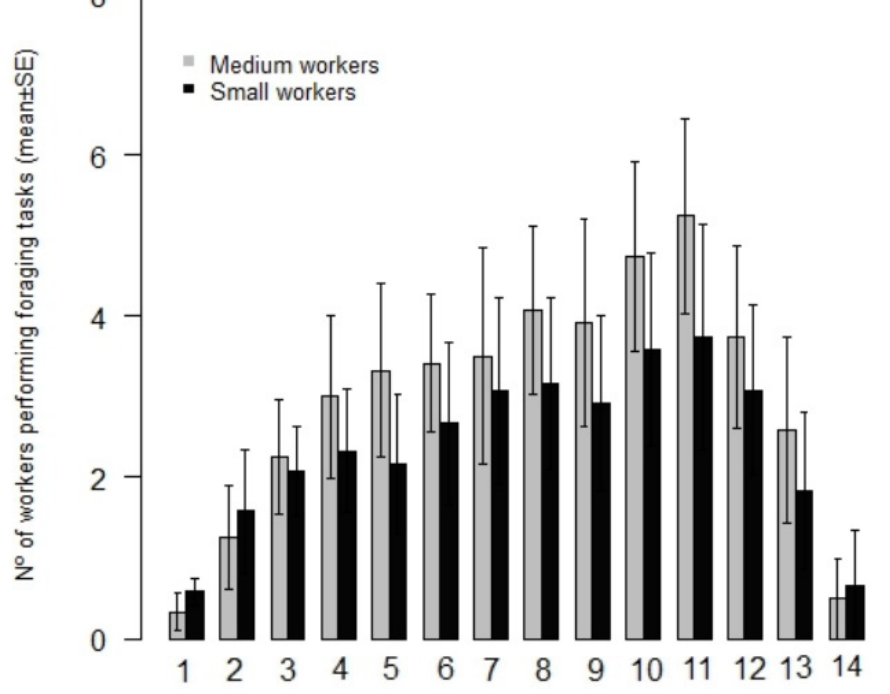
Fig 2 . Average number of medium and small-sized workers (± SE) performing foraging tasks each